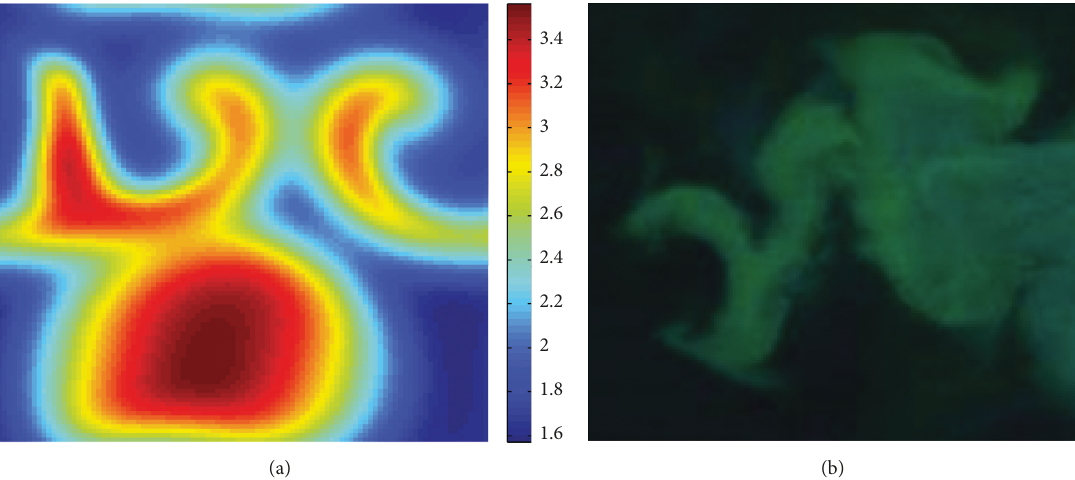
� 0 . 2, d � 0 . 2, q � 0 . 01, τ � 3, 1 2